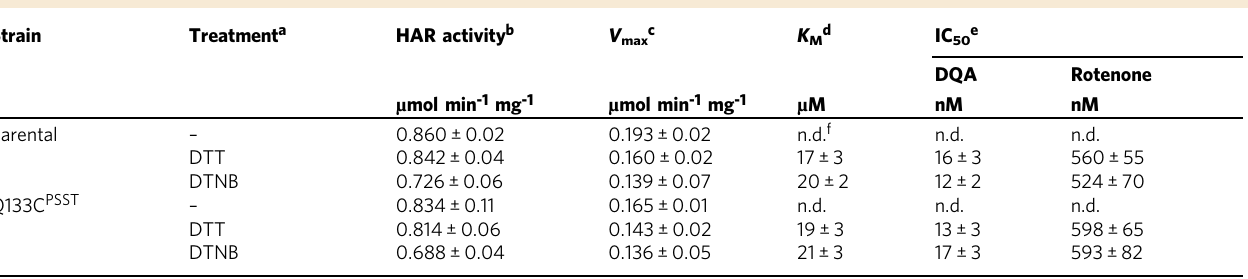
Table 1 Functional characterization of complex I in mitochondrial membranes Strain